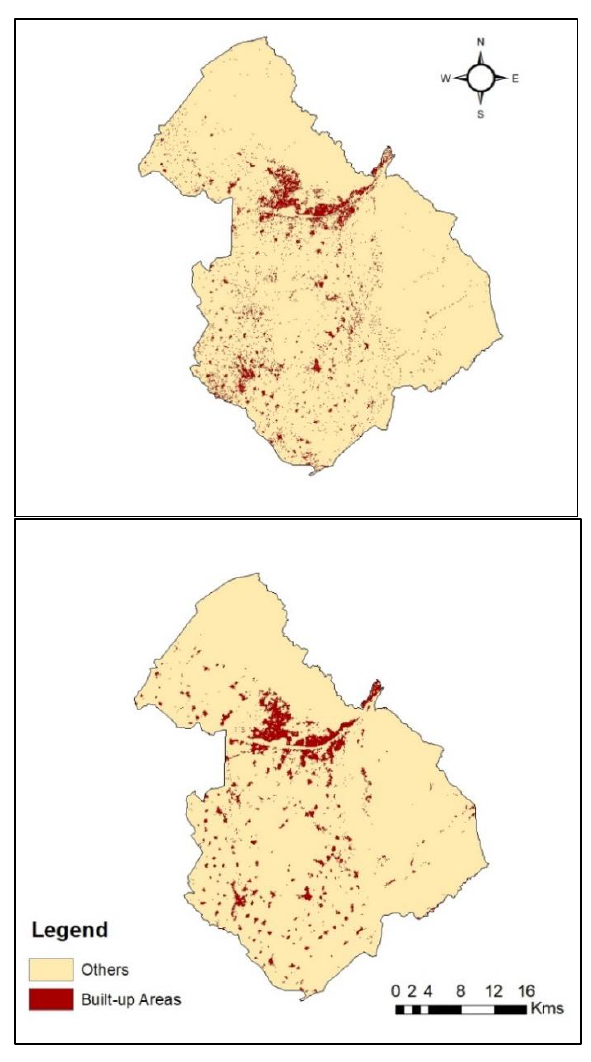
Figure 7. (a) Built-up area map using Landsat OLI spectral bands (b) built-up area map using selected